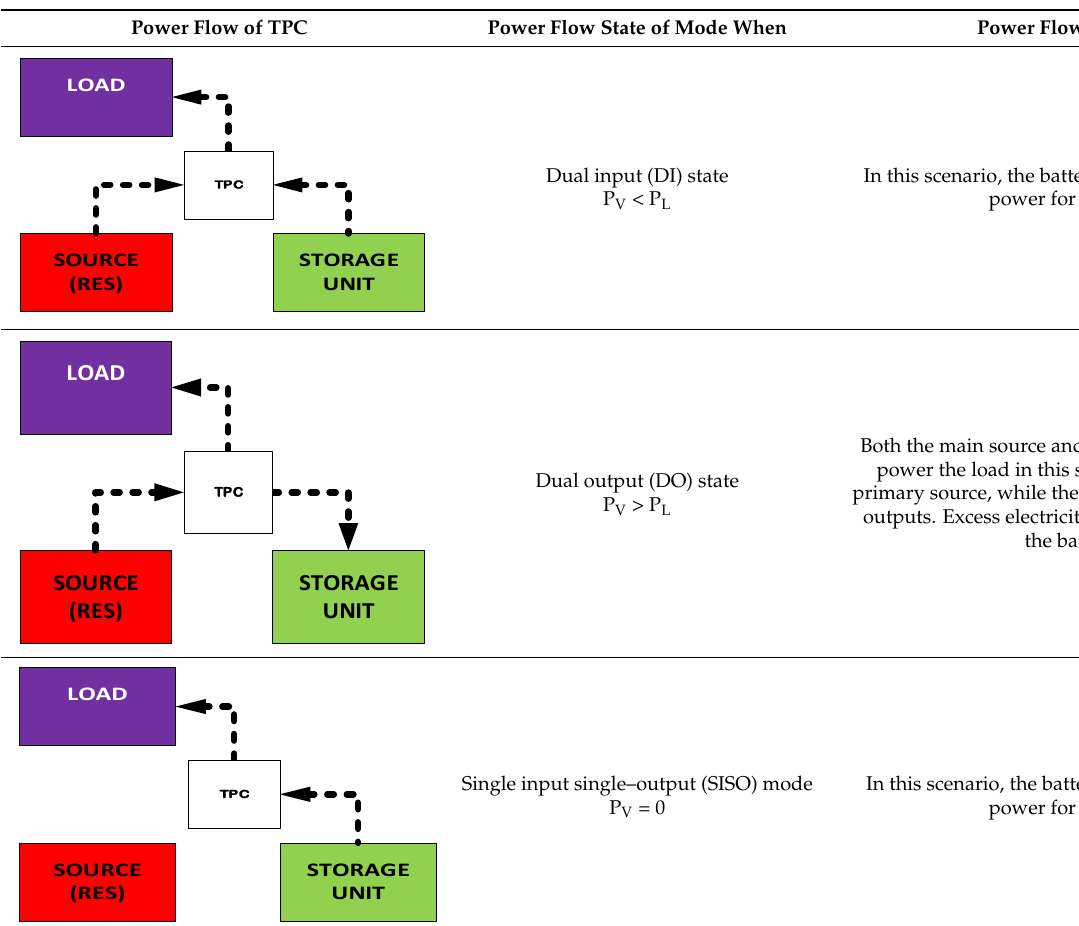
Table 4. Power flow of a TPC-integrated non-isolated MPC topology.